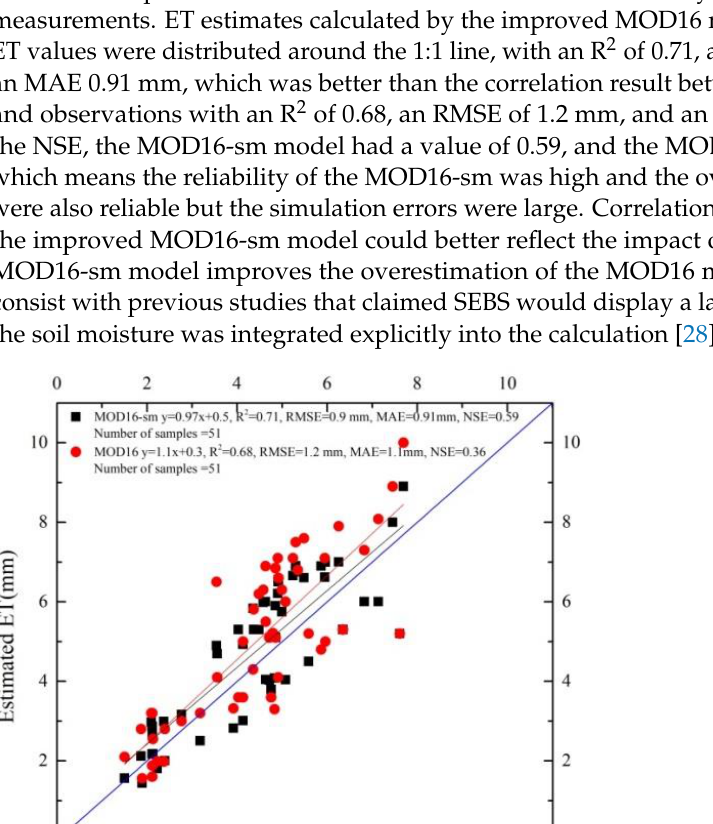
Table 2. Daily average ET comparisons on monthly scale. Stations